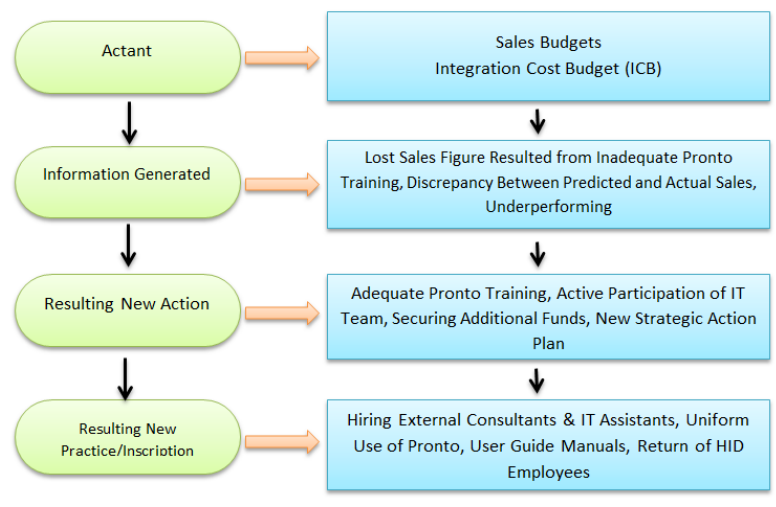
Figure 3. Performative role of budgets in the acquiring company systems integration.